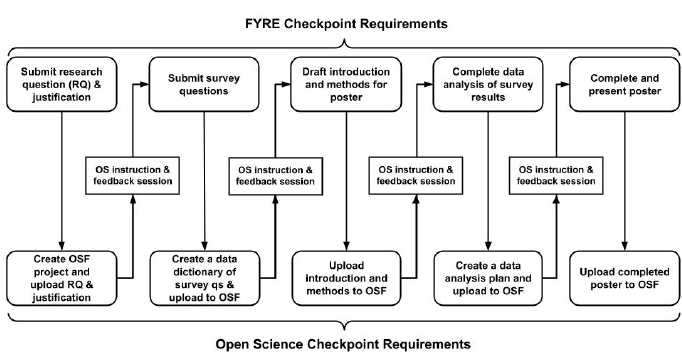
Figure 1 Open science checkpoint activity